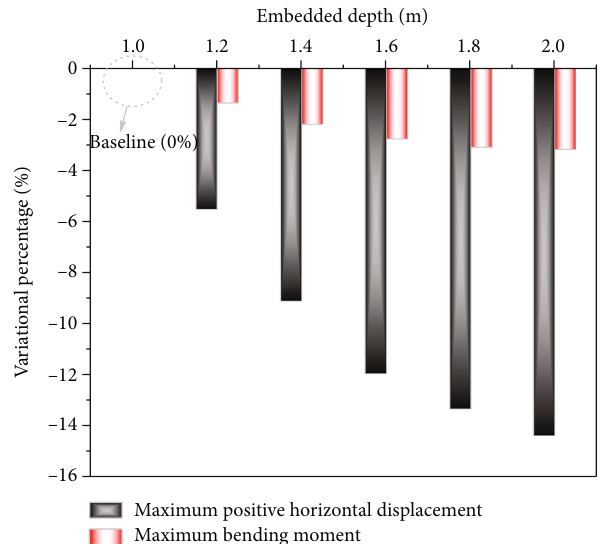
Figure 22: Variations of the maximum positive horizontal displacement and maximum bending moment of the end- suspended pile at di ff erent embedded